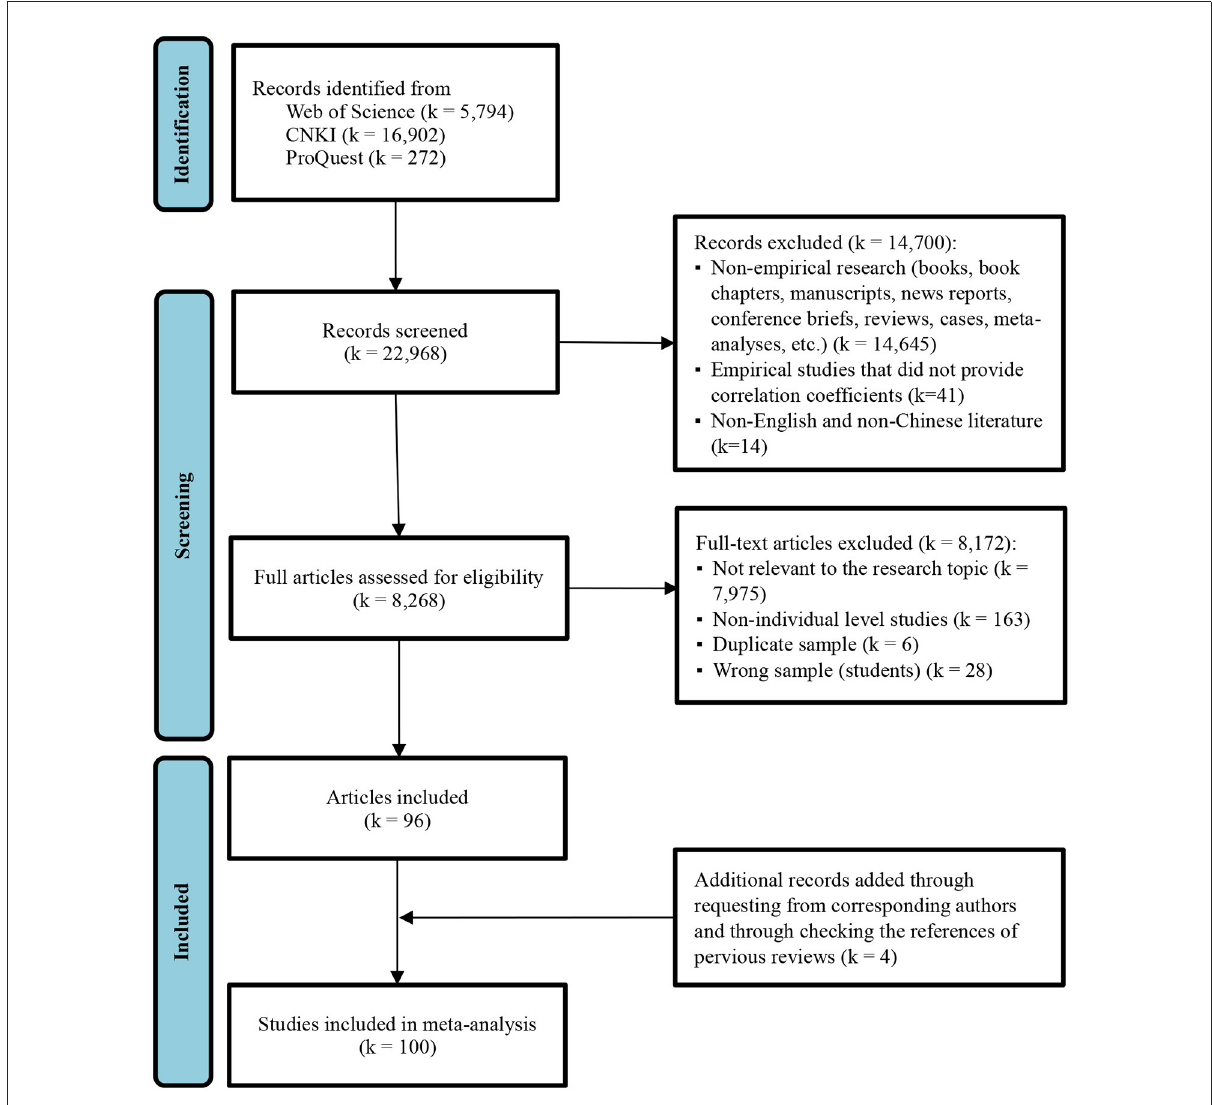
FIGURE1 Flowchart of the study selection process.